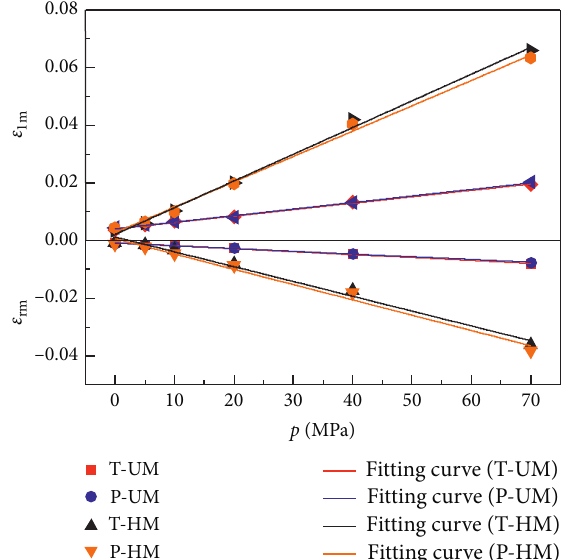
Figure 13: ε 1m - p and ε rm - p curves of